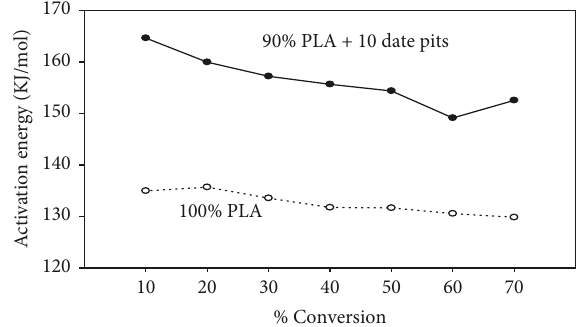
Figure14:NeatPLAand90%PLA+10%datepits:activationenergy as a function of percent degradation conversion.